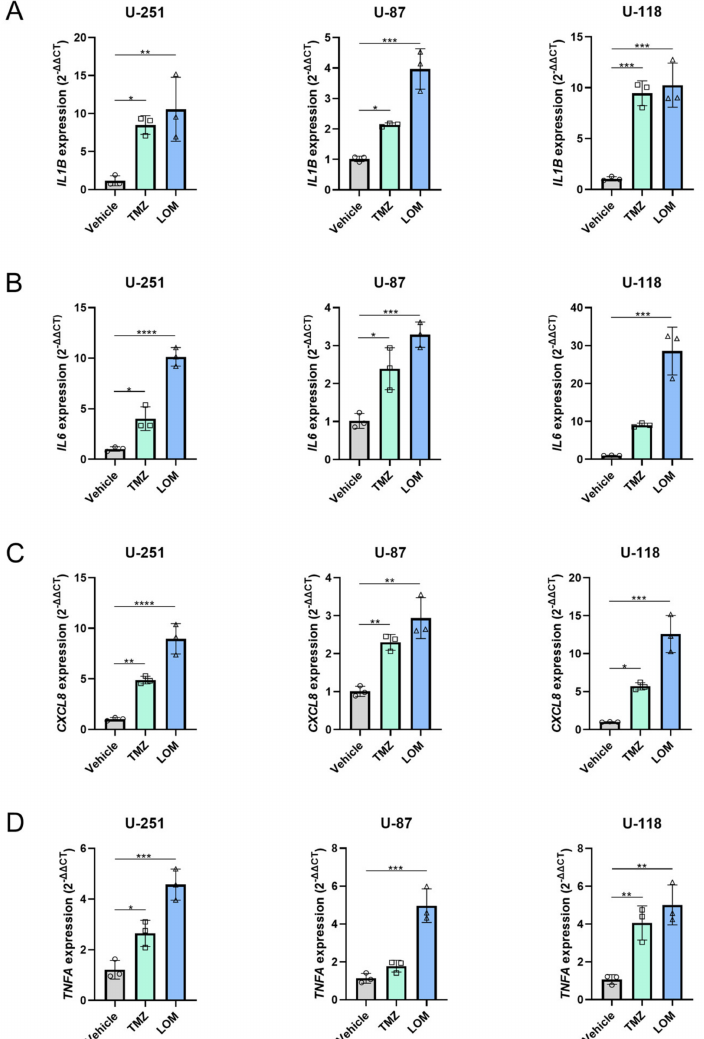
Figure 5. TMZ- and LOM-induced expression of the proinflammatory genes IL1B , IL6 , CXCL8 and TNFA in GBM cells. qPCR analysis showed increased mRNA expression levels of IL1B ( A ), IL6 ( B ), CXCL8 ( C ) and TNFA ( D ) upon treatment of U-251, U-87 and U-118 cells with the chemotherapeutic agents TMZ (100 µ M) and LOM (30 µ M) for 72 h. Housekeeping genes GAPDH and ACTB were used for normalization. Representative experiments are shown ( n = 3) from biological triplicates for each condition in technical triplicate. One-way ANOVA with Tukey’s multiple comparison test was used for statistical evaluation. * p < 0.05, ** p < 0.01, *** p < 0.001, **** p < 0.0001 vs vehicle (DMSO). Abbreviations: TMZ, temozolomide; LOM,